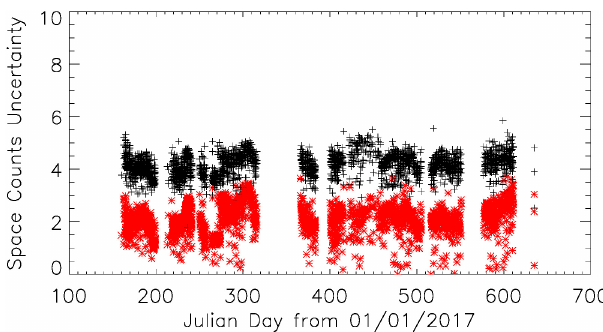
Figure 4. Time series of σ sp before the ML/AI model fitting (black crosses) and after the fitting (red crosses). Each cross represents one